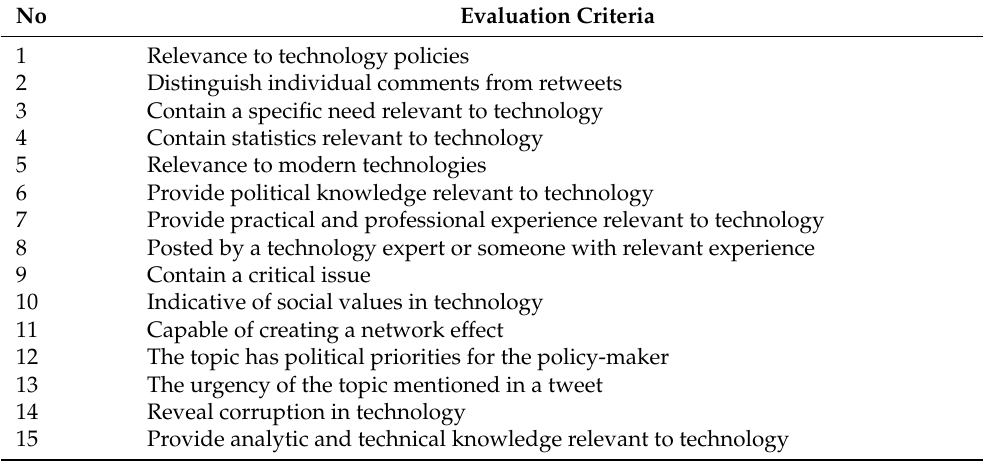
Table 1. The evidence evaluation criteria in the field of technology policy from the perspective of